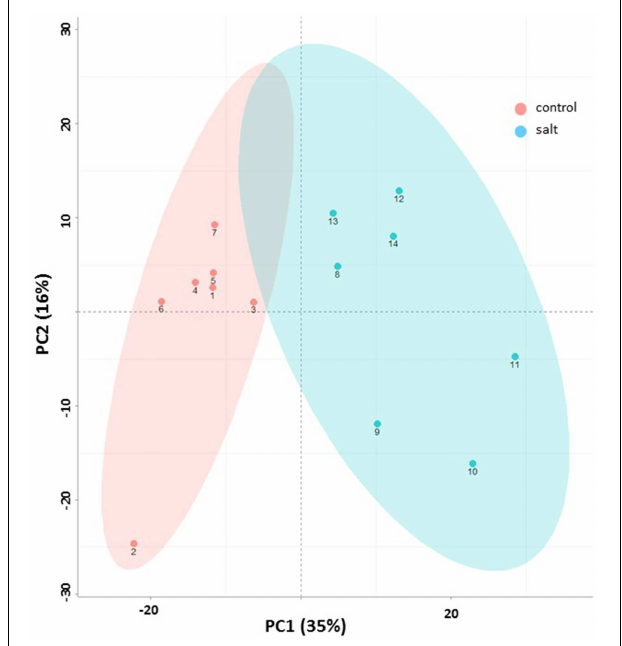
FIGURE 3 | Metabolic changes associated with salinity. Principle component analysis (PCA) plot (x – first component, y – second component) of control (pink) and salt-treated (blue) EBC extract of GC/MS based metabolites. Symbol numbers represent the different biological replicates (1–7, control replicates; 8–14, salt-treated replicates). Colored ellipses (based on the Hotelling’s T2 95% confidence interval) are used to display experimental group